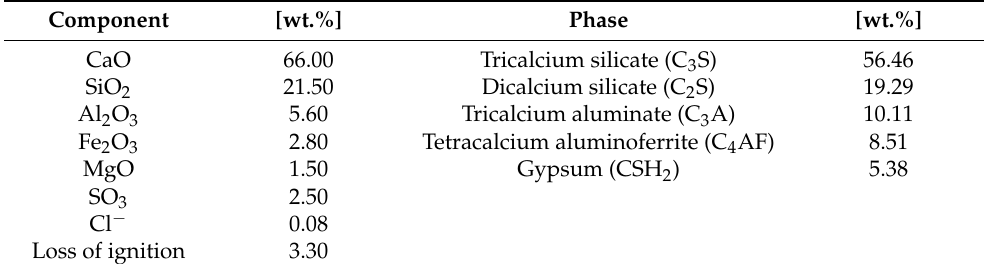
Table 1. Chemical and phase composition of Portland cement CEM I 42.5R.